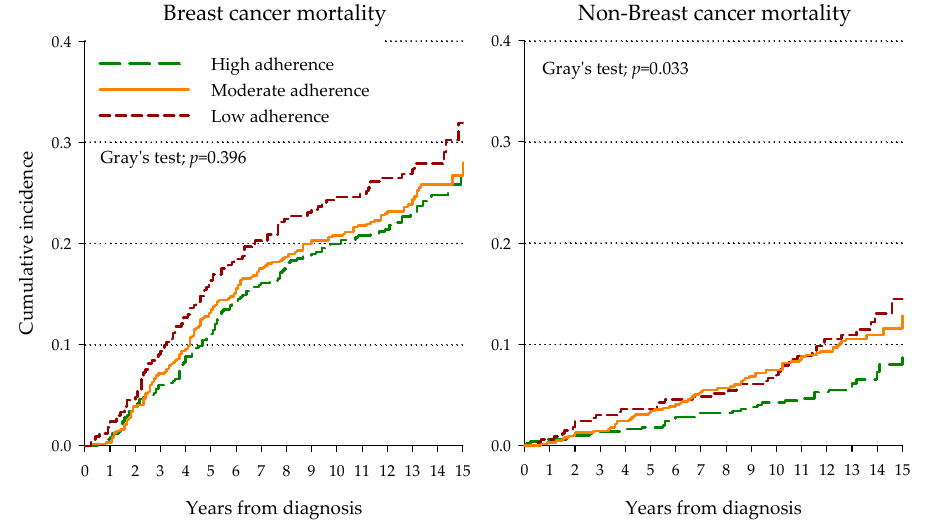
Figure 2. Kaplan–Meier estimates of cumulative incidence of breast cancer and non-breast cancer mortality according to adherence to Mediterranean diet.